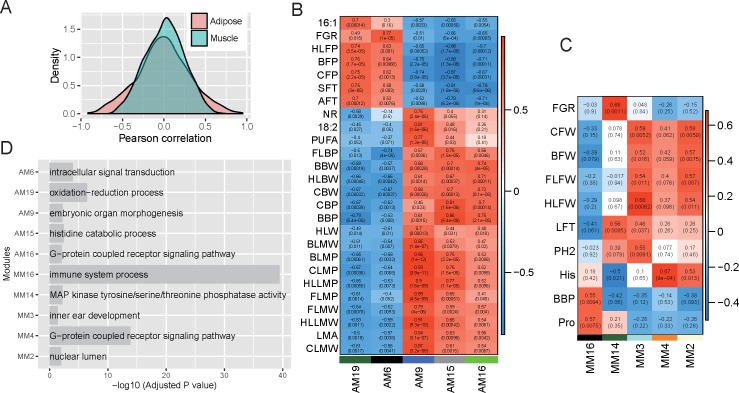
Higher correlation between adipose modules and traits than for muscle modules.(A) The distribution of Pearson’s correlation between the module eigengene and traits for adipose and muscle tissues. (B) The module eigengene significance of adipose tissue. The displayed traits and modules have at least Pearson’s correlation r>0.7 and P<0.01. Cell color represents the correlation (red, positive correlation; blue, negative correlation, according to the color legend). Two numbers in each cell show the correlation level (upper) and correlation significance (lower in the parentheses). Rows represent traits and columns represent coexpression modules. (C) The module eigengene significance of muscle tissue. The displayed traits and modules have at least Pearson’s correlation r>0.5 and P<0.01. The cell color, numbers in each cell, and X and Y axes have the same meanings as those in B. (D) The enriched Gene Ontology biological processes for the selected modules in adipose and muscle tissues. The height of the bar corresponding to the minus log10-transformed adjusted P value. A: adipose, M: muscle.